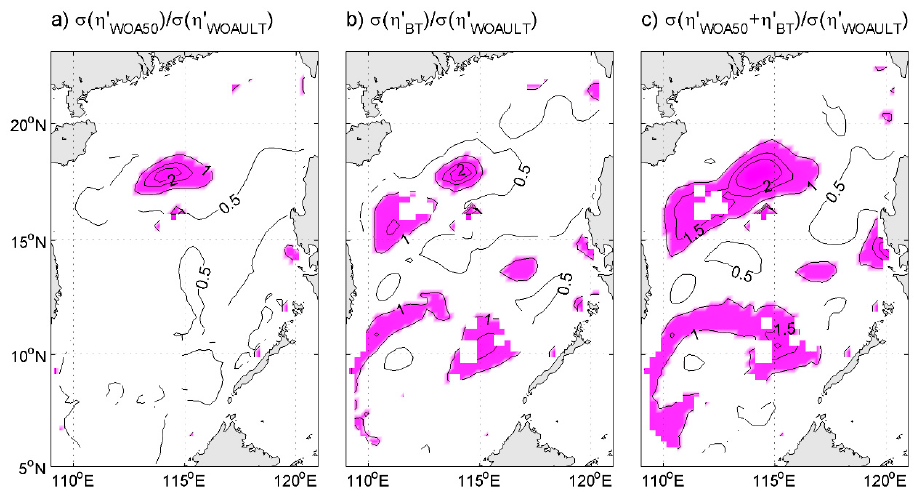
Figure 12. The ratio of the standard deviation ( a ) between η (cid:48) η (cid:48) ; and ( c ) between η (cid:48) WOAULT